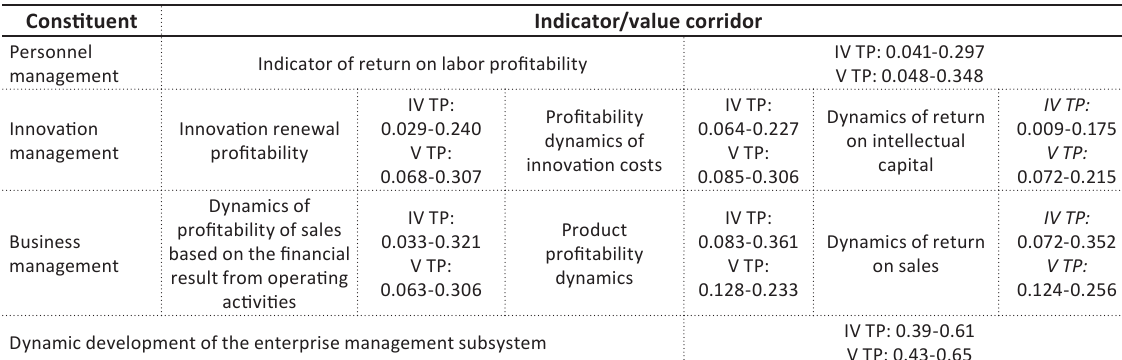
Table 2. Target values of the development of the enterprise management subsystem to form an effective project portfolio